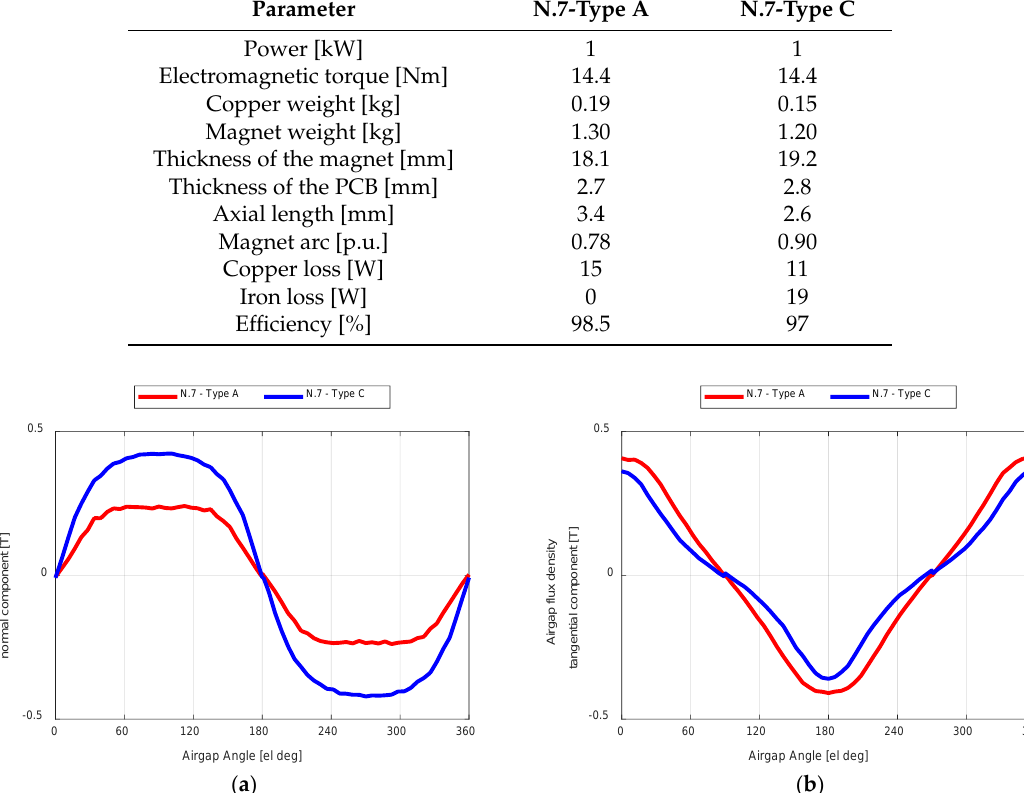
Figure 16. Airgap flux density of the two machines FE-analyzed. Normal ( a ) and tangential ( b ) components.